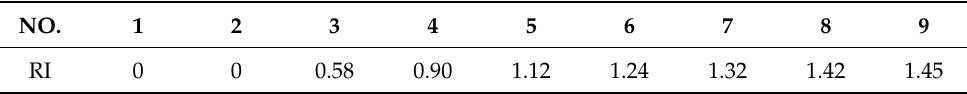
Table 3. RI value for calculating CR by Saaty